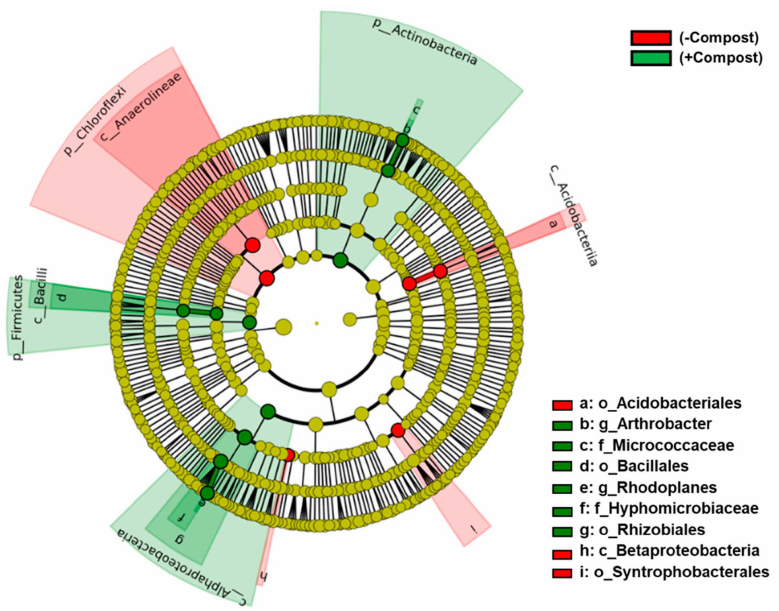
Figure 3. The significantly different taxa of bacteria between two soil samples depicted by linear discriminant analysis effect size (LEfSe) method. The significantly different abundant taxa among treatments are denoted by colored dots, and from the center to the outer circle, they represent the kingdom, phylum, class, order, family, and genus. The trends of the significantly different taxa are represented by colored dots.